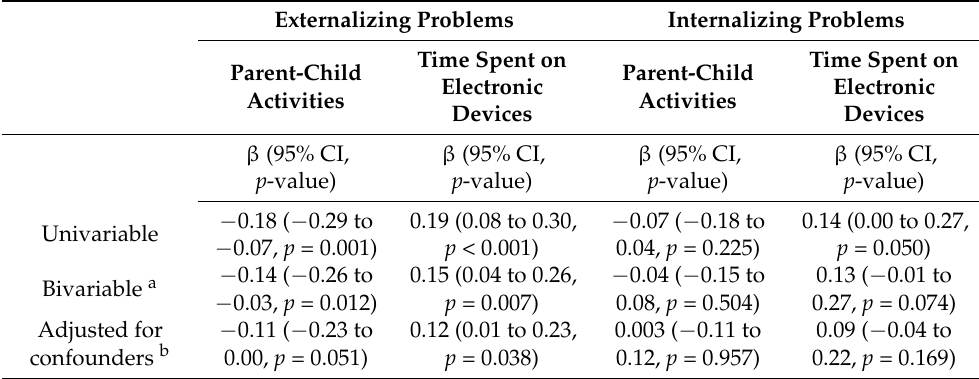
Table 2. Longitudinal effect of parent–child and child screen activities on later externalizing and internalizing problems.